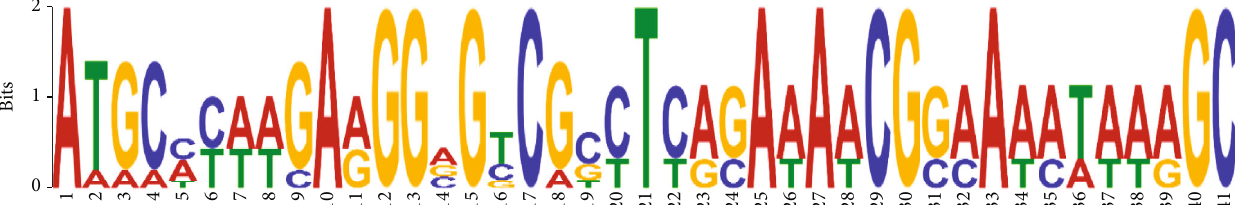
Figure 1: Sequence logos for mercuric bioremediation identi fi ed common motifs. The analysis was done by the MEME